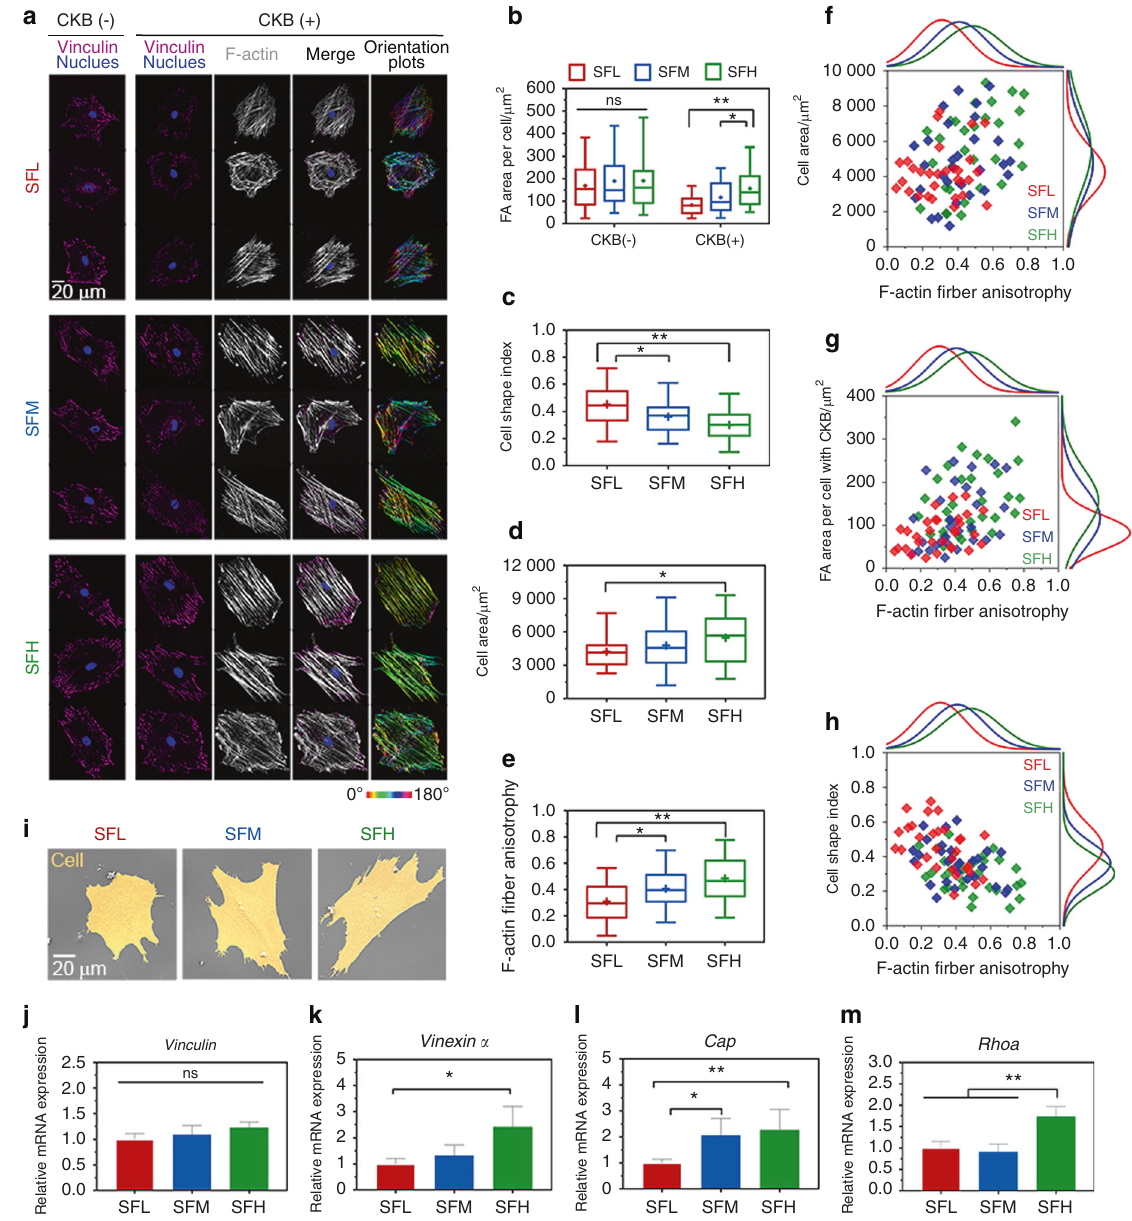
Fig. 4 Spreading behavior of BMSCs on different SF substrates. a Representative mosaic immuno fl uorescence images of vinculin (purple), F-actin (white), and nuclei (blue) in BMSCs without and with CKB treatment and the corresponding orientation plots for F-actin staining, where the different colors indicate different orientations of actin fi laments as per the given color map. b – e Quantitative analysis of ( b ) FA area per cell, ( c ) cell shape index, ( d ) cell area, and ( e ) F-actin anisotropy in BMSCs. f – h Single-cell scatter plots of F-actin anisotropy as a function of ( f ) cell area, ( g ) FA area per cell, and ( h ) cell shape index. i SEM images of BMSCs ’ spreading morphology. j – m The mRNA expression levels of ( j ) Vinculin , ( k ) Vinexin α , ( l ) Cap , and ( m ) Rhoa in BMSCs. For each box plot, the box boundaries represent the 25th – 75th percentiles, and the whiskers represent the min and max values. The central line and cross represent the median value and mean, respectively. Error bars represent one standard deviation. (* P < 0.05 and ** P < The single-cell scatter plots (Fig. 5e) revealed a trend positively day 1. In contrast, RUNX2 showed obvious nuclear translocation correlating the high nuclear ratio of YAP/TAZ with that of RUNX2, for all three substrates at day 3, and more RUNX2 was translocated which indicates that RUNX2 might be nuclear translocated along from the cytoplasm to nucleus on SF substrates with an increase in β -sheets. The quantitative analysis (Fig. 5c) demonstrated that the with YAP/TAZ. The expression of Yap in BMSCs was comparable for all different nuclear-cytoplasmic ratio of RUNX2 in BMSCs was signi fi cantly material surfaces at 24 h and day 3 (Fig. 5f, g). While the higher on SFH vs. SFM ( P < 0.05) and SFL surfaces ( P < 0.01) at day 3, expression of Ankrd1 and Ctgf was upregulated in the SFH samples while it was comparable among all three SF surfaces at day 1. compared to the SFL samples at 24 h and day 3 (Fig. 5h – k), Runx2 Moreover, quantitative measurement of the fl uorescence intensity expression was only upregulated with increased β -sheet content of RUNX2 per cell (Fig. 5d) indicated that RUNX2 expression in of the materials at day 3 (Fig. 5l, m). BMSCs was also higher on SFH than SFM at day 3.